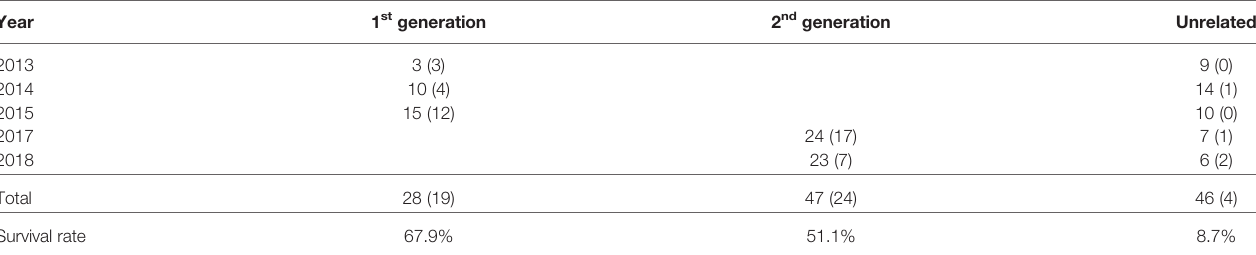
second-generation and 46 unrelated animals. The survival data for TABLE 2 | Summary of survival outcomes for progeny and unrelated animals over the course of fi ve fi eld studies.